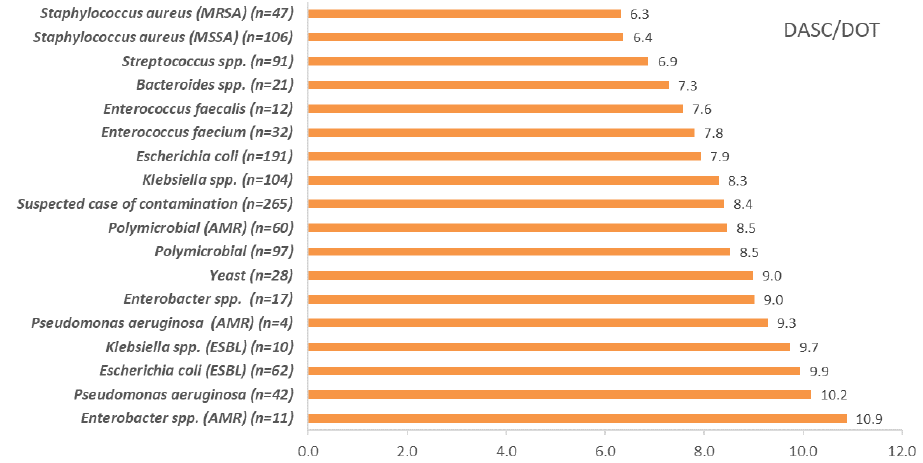
Figure 7. The DASC/DOT distribution stratified by BSI pathogens. DASC, days of antibiotic spectrum coverage; DOT, days of therapy; MSSA, methicillin-susceptible Staphylococcus aureus ; MRSA, methicillin-resistant Staphylococcus aureus ; ESBL, extended-spectrum beta-lactamase; AMR, antimicrobial resistance.